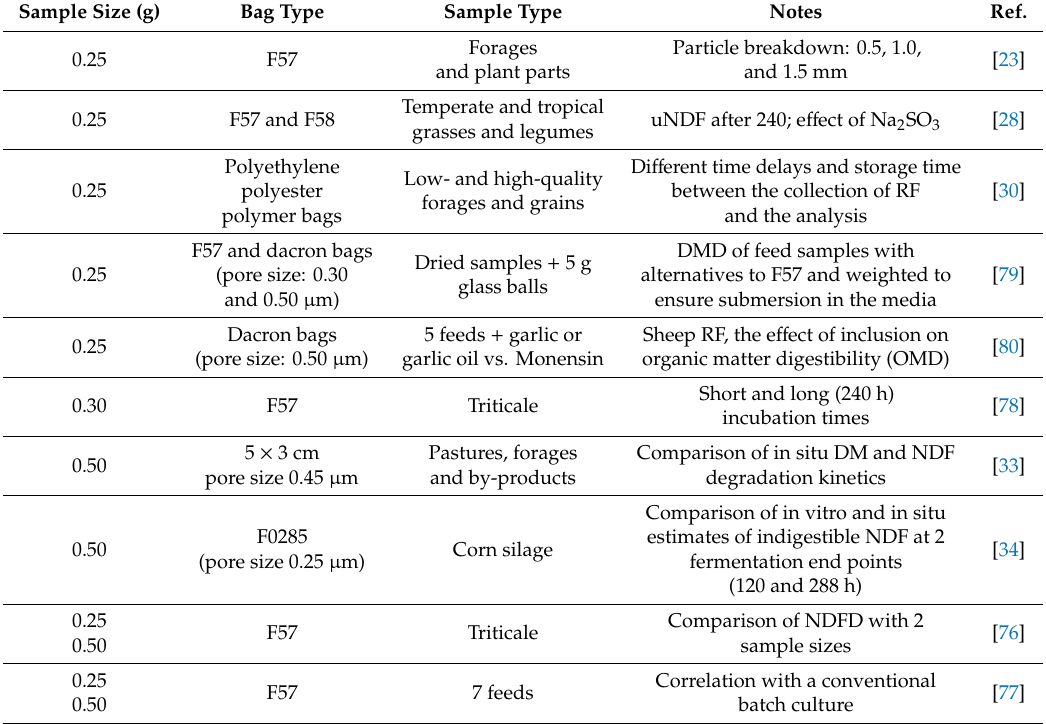
Table 2. Sample size and bag type applied to the Ankom Daisy II incubator (AD II